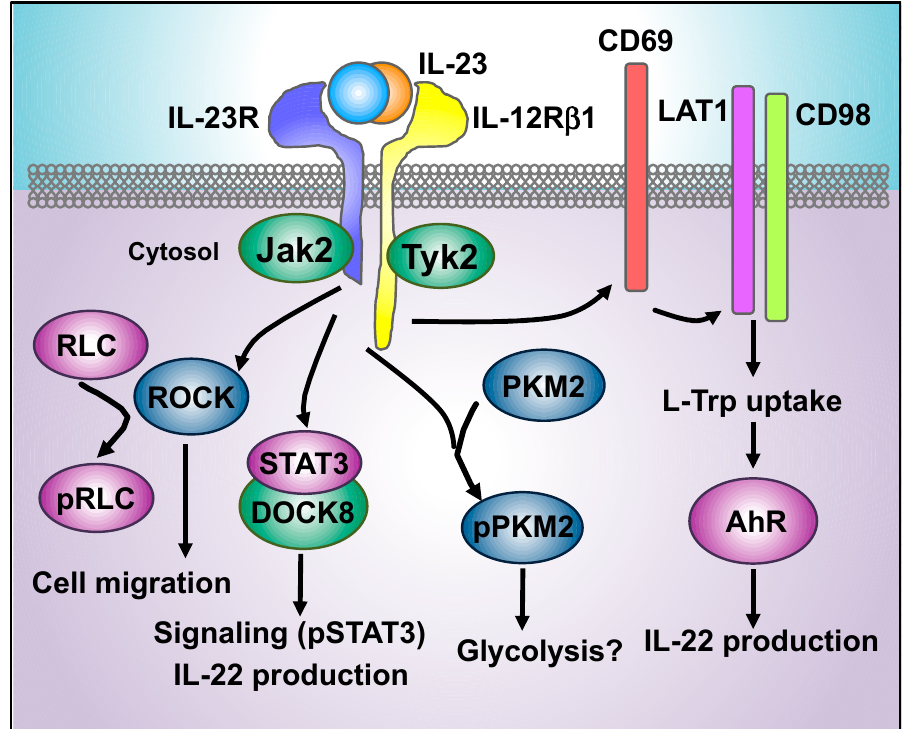
Figure 3. New players in IL-23 proximal signaling events. IL-23 promotes phosphorylation of the myosin regulatory light chain (RLC) via Jak2 and ROCK activation, and IL-23 induces migration of T γδ 17 and Th17 cells in a ROCK dependent manner. The association of the Dedicator of cytokinesis 8 (DOCK8) to STAT3 is required for sustained STAT3 phosphorylation and IL-22 production downstream IL-23. IL-23 triggered the phosphorylation of pyruvate kinase isoform PKM2-Ser37 residue, promoted its nuclear translocation, and induced the expression of PKM2 downstream target genes. IL-23 induces CD69 expression, and CD69 associates with LAT1 / CD98 amino acid transporter to promote L-Trp uptake. Derivatives from L-Trp metabolism activate AhR to induce IL-22 production in T γδ 17 cells.